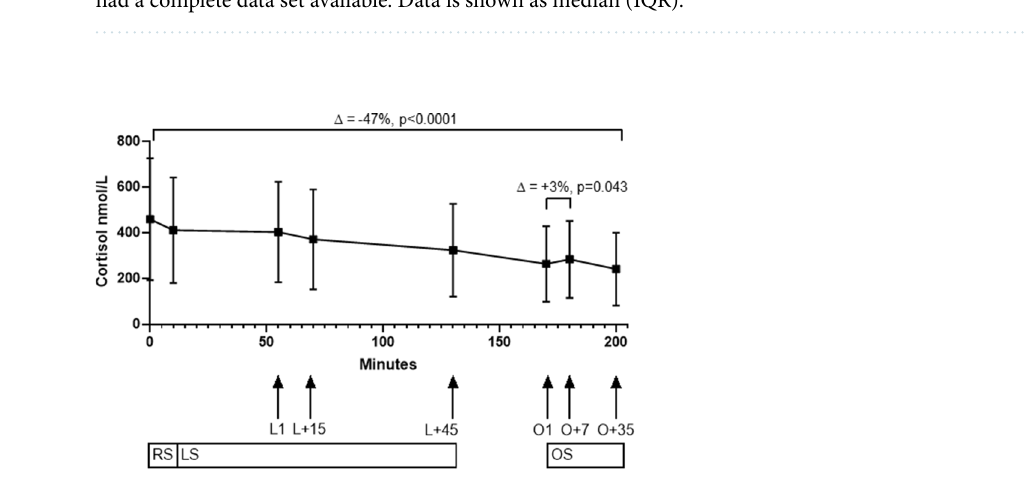
Table 2. Biomarker levels at each timepoint. n = 21 includes only subjects who completed all test sessions and had a complete data set available. Data is shown as median (IQR).